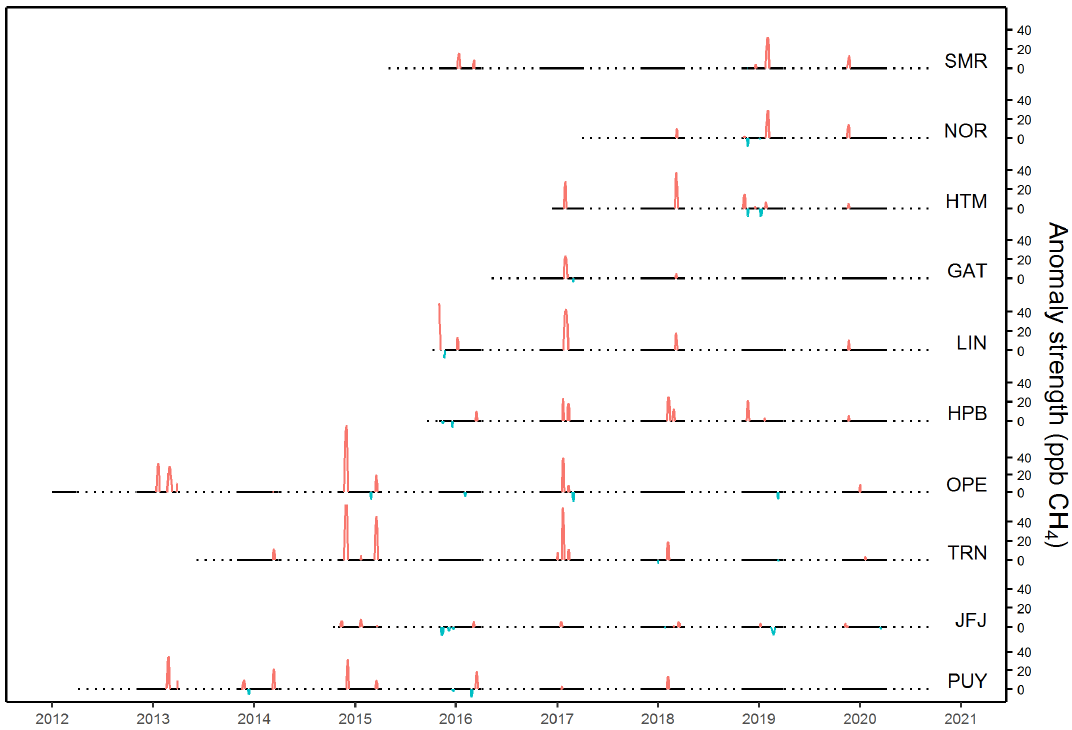
Figure 7. Positive (red) and negative (blue) SSAs in the complete CH 4 records of each site.